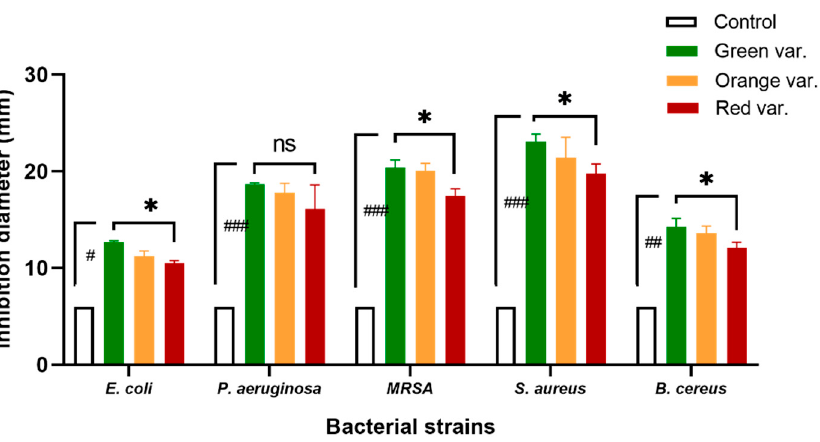
Figure 4. Histograms of inhibition zones obtained with 3 varieties of cactus root extracts. #: weak antibacterial activity, ##: moderate antibacterial activity, ###: high antibacterial activity [66], ns: none significative, *: significant difference ( p = 0.05) between the three varieties using Tukey’s HSD test.